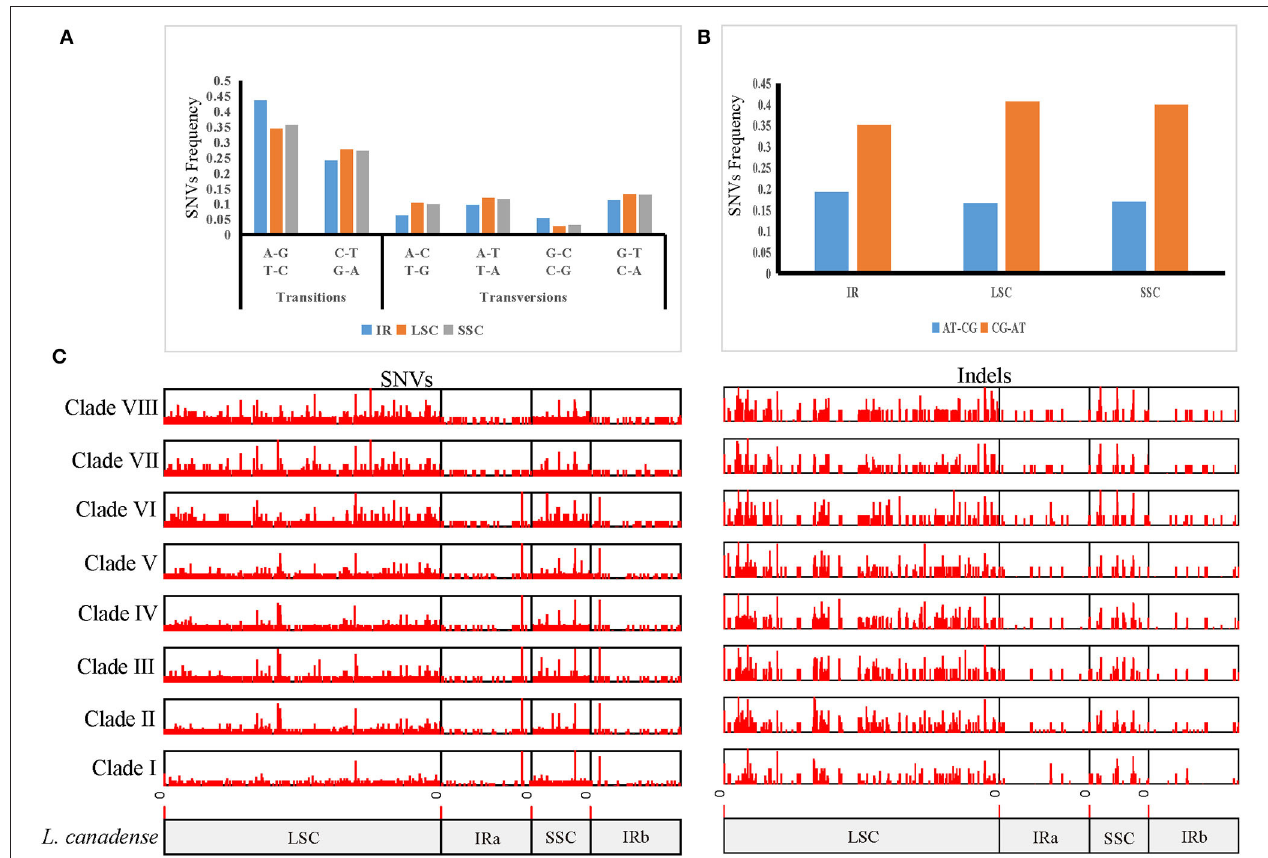
FIGURE 3 | Mutation patterns in Lilium plastomes. (A) Mutation spectra of the IR, LSC, and SSC regions. (B) AT-biased mutations in the IR, LSC, and SSC regions. (C) Distribution of indels and SNVs along plastomes among eight Lilium clades. Mutations were found within each clade compared to L. canadense , which belongs to Clade